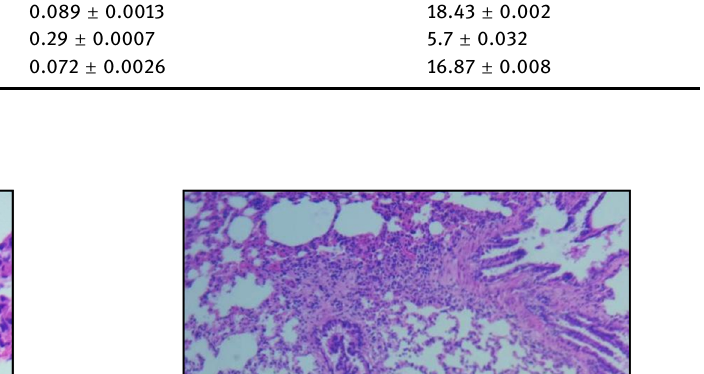
Table 9: MDA and GSH levels No.